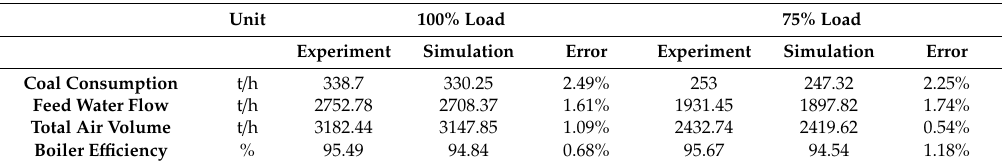
Table 3. Comparison of main parameters of boiler operation between experiment and simulation. Unit 100% Load 75% Load Experiment Simulation Error